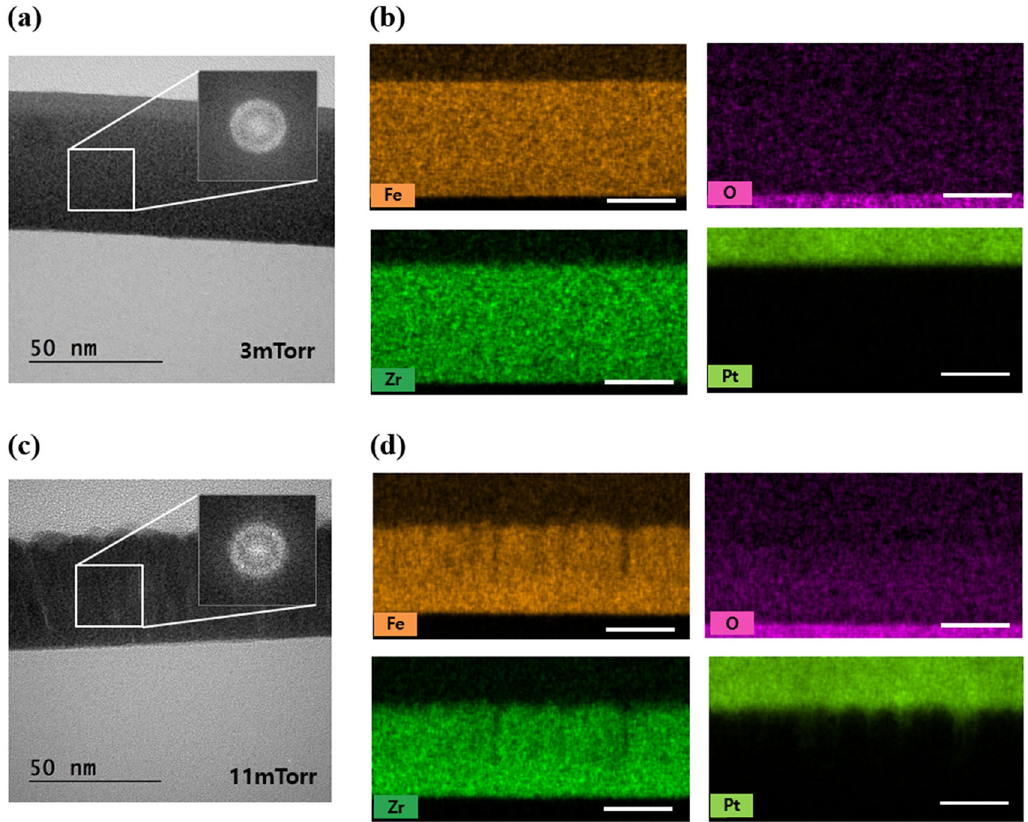
Fig. 3 Analysis of structural properties of amorphous metal. a The transmission electron microscope (TEM) image of FeZr deposited at 3mTorr. Inset shows the fast-Fourier-transform (FFT) data. b The energy dispersive X-ray spectroscopy (EDS) data of FeZr deposited at 3mTorr. Scale bar is 30 nm. c TEM image (inset shows the FFT data) and d EDS data of FeZr deposited at 11mTorr. Scale bar is 30